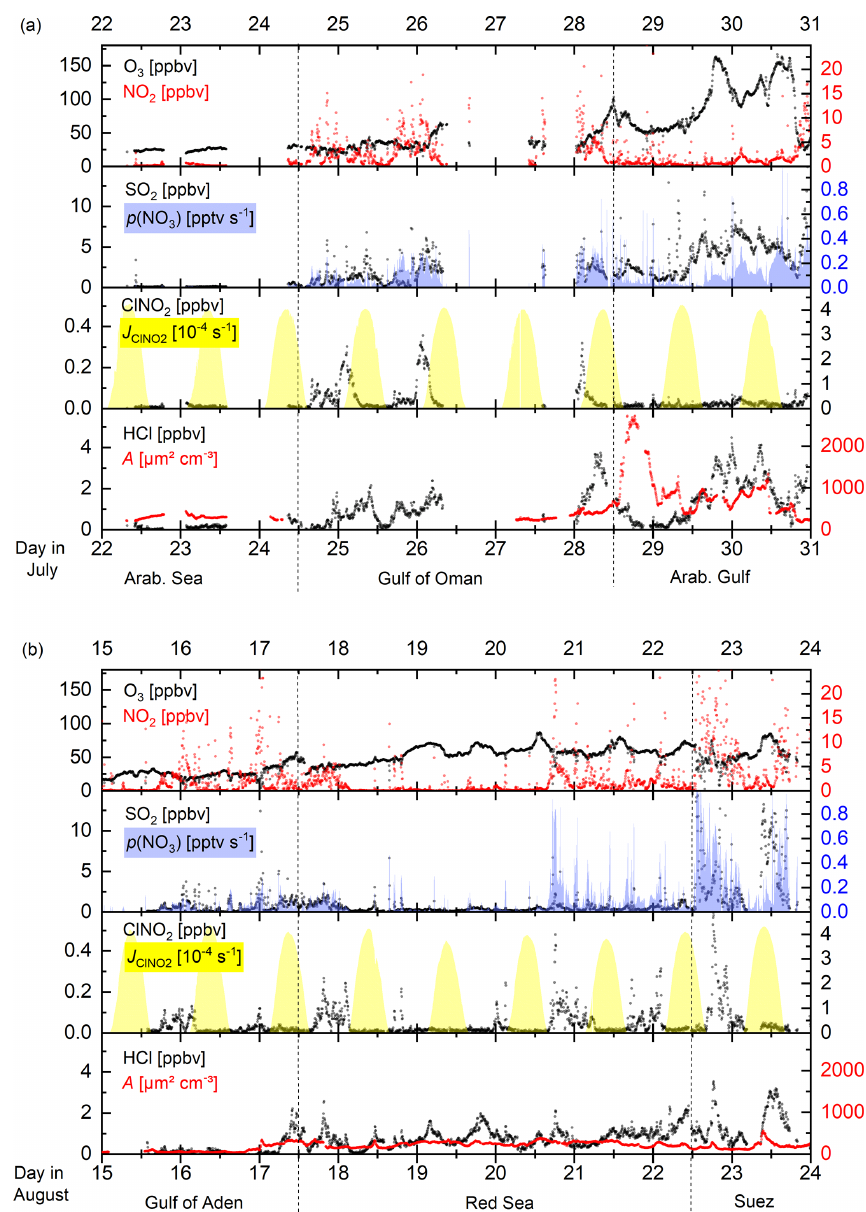
Figure 3. Time series of ClNO 2 and trace gases related to its production (NO 2 and O 3 ) as well as the NO 3 production rate, p (NO 3 ), ClNO 2 photolysis rate ( J ClNO ), PM 1 particle surface area concentration ( A ), and HCl mixing ratio in different regions (separated by the dashed 2 lines) for 9d periods in the (a) first and (b) second